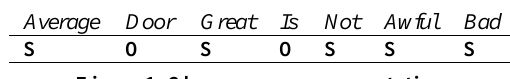
Figure 1. Chromosome